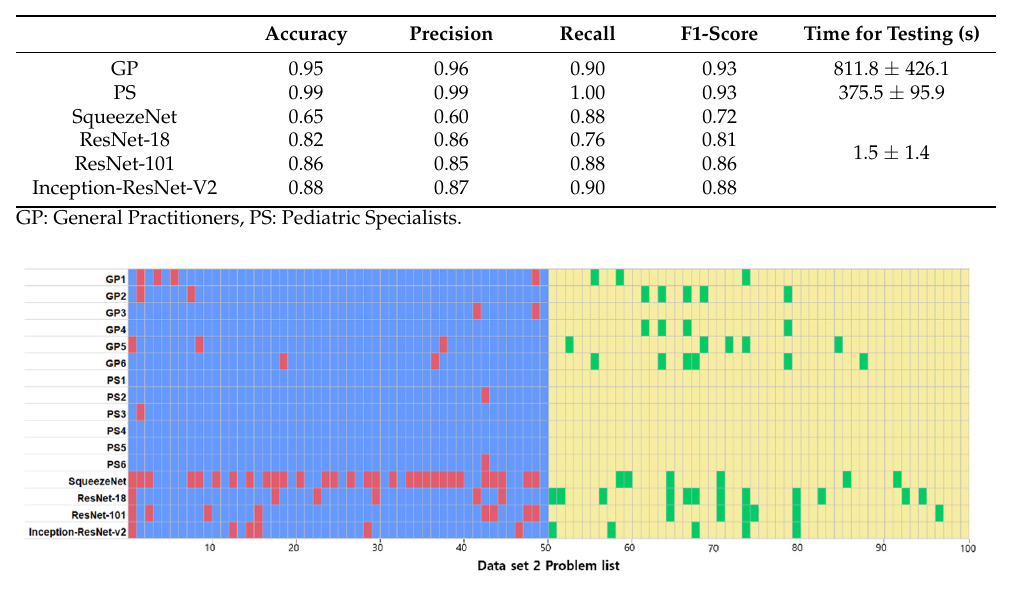
Table 4. Comparison of diagnostic performances of deep-learning models and human groups.